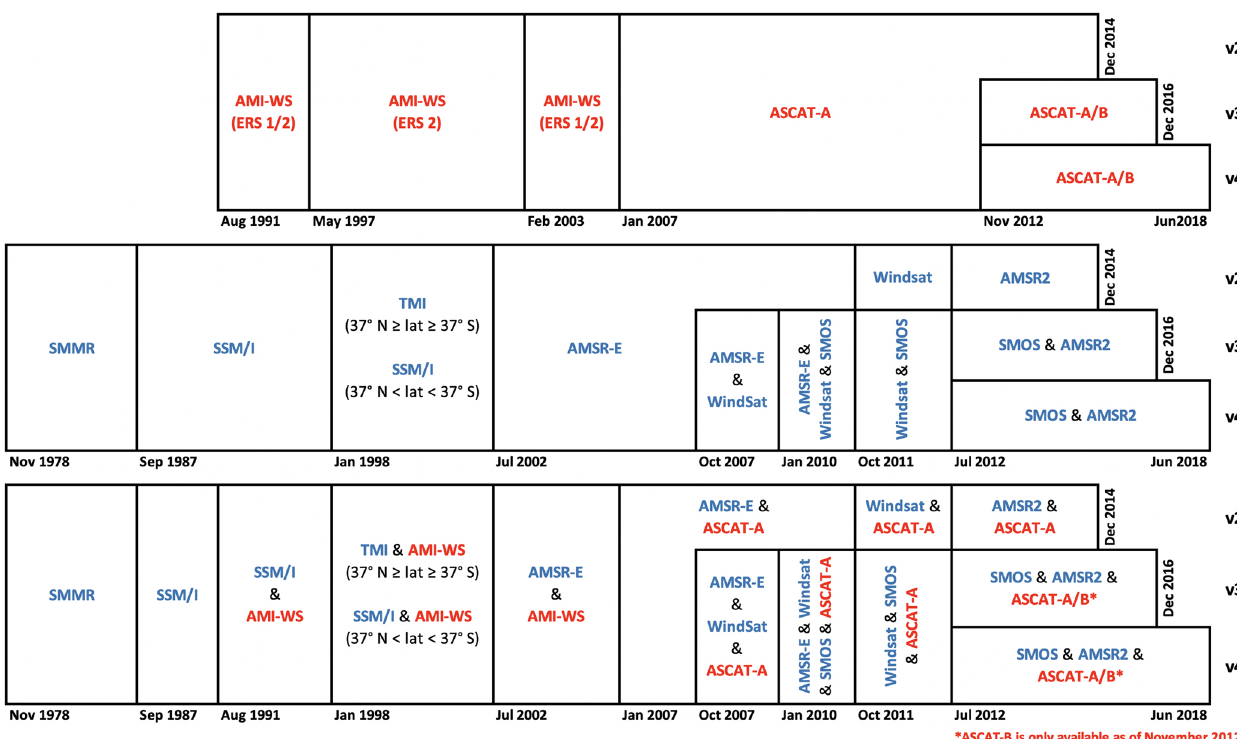
Figure 2. Merging periods and sensor selection of the ACTIVE (top), PASSIVE (middle) and COMBINED (bottom) ESA CCI SM v2, v3 and v4